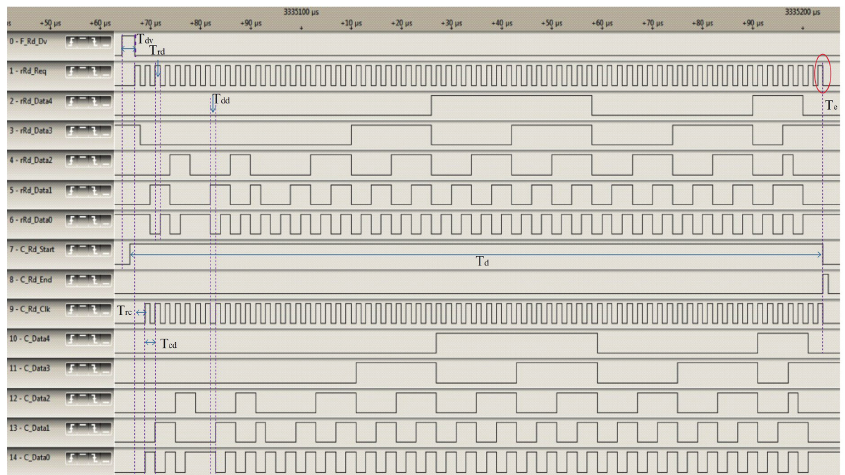
Figure 12: Data and Timing Waveform when I/O Multiplexer Sending Data to CC2530, via Salea16.